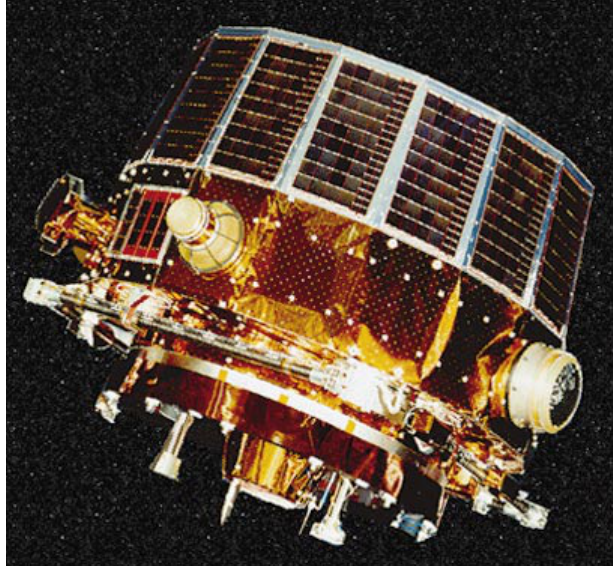
Fig. 2. Equator-S operational orbits projected into the GSE X-Y plane. Grey shading indicates the region of data coverage